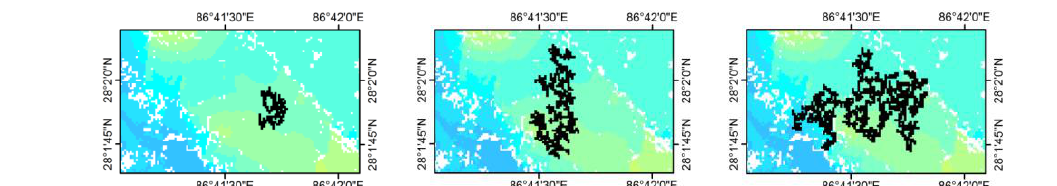
Figure 4. The polygons of increasing size imposed in key location of displacement map from pair II (shown in red box in Figure 3(f)) for accuracy assessment of growing gap size. Artificial gaps imposed are: polygon 1 (142 pixels), Polygon 2 (499 pixels) and Polygon 3 (1016 pixels) from left to right respectively shown in black